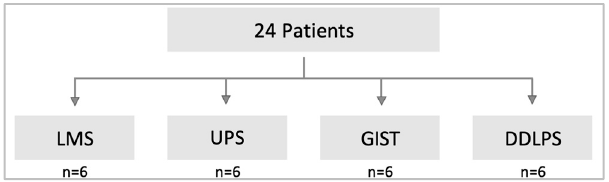
Figure 1. Schema of subject grouping. 24 subjects were dived into four cohorts based on diagnosis namely: leiomyosarcoma (LMS), undifferentiated pleomorphic sarcoma (UPS), gastrointestinal stromal tumor (GIST), and dedifferentiated liposarcoma (DDLPS). Circulating tumor DNA (ctDNA) were detectable in blood as follows: 6/6 LMS, 5/6 UPS, 4/6 GIST, 3/6 DDLPS.